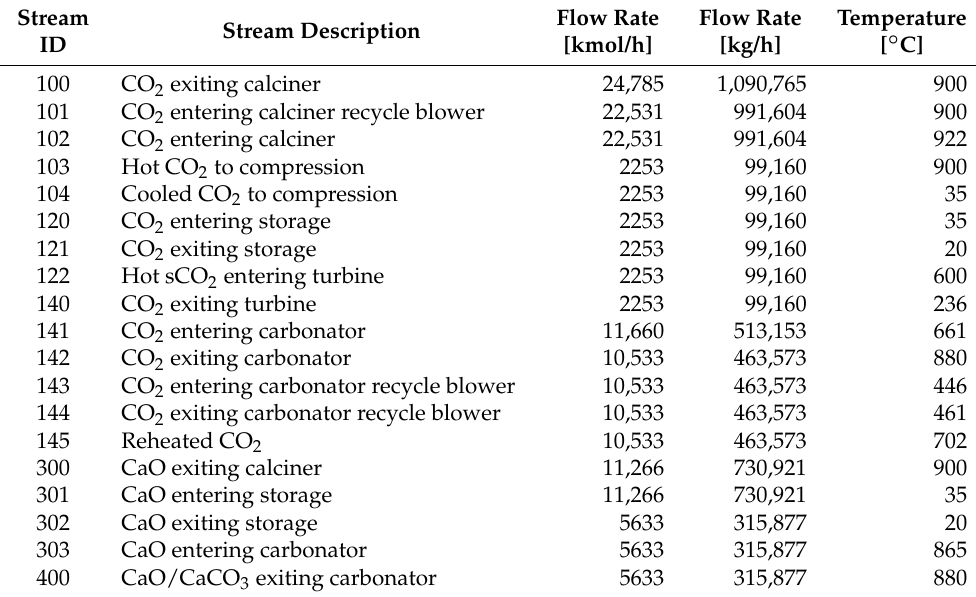
Table A3. Configuration 2 base case material stream